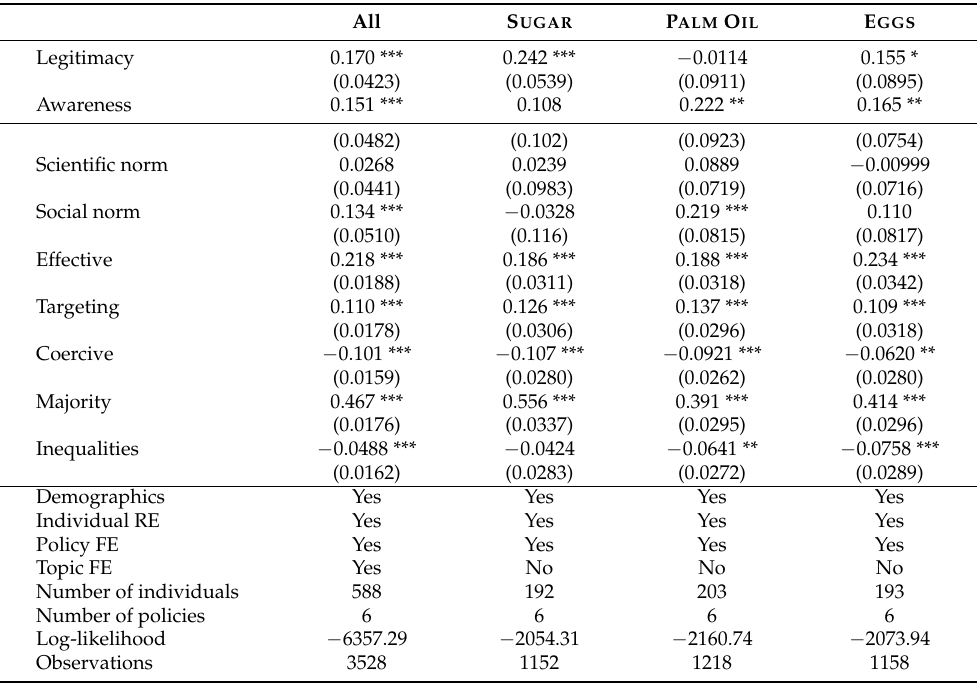
Table A7. Regression of individual acceptability —confirmatory analysis.